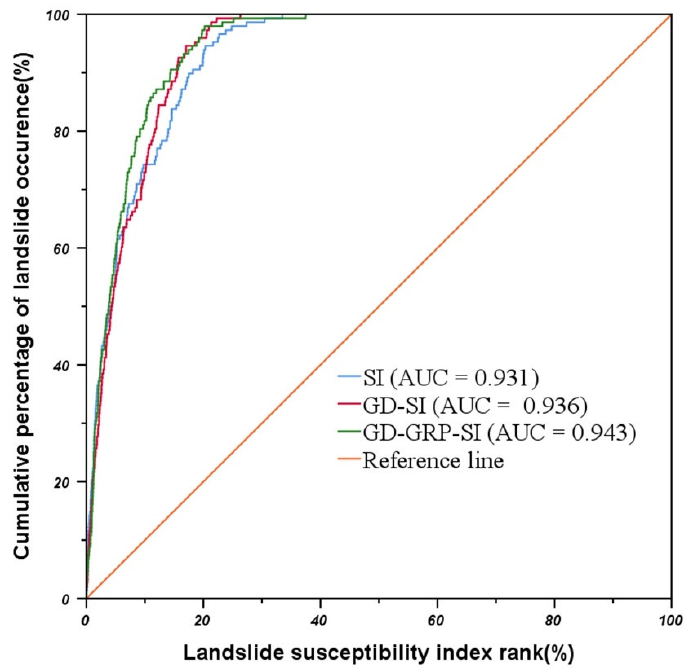
Figure 11. ROC curves of different models on the testing dataset.